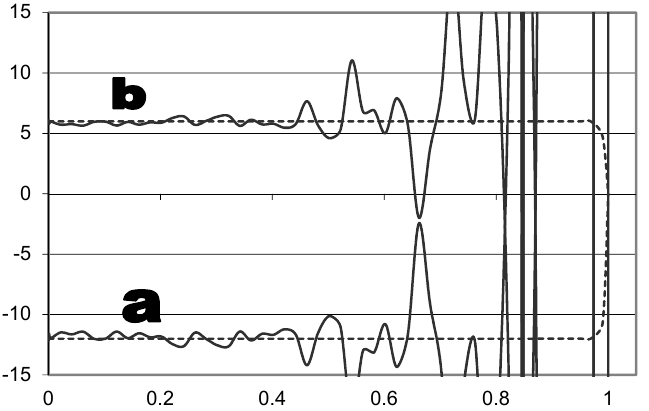
Figure 4. Shrinking horizon prediction control problem: Time ‐ varying values of integration constants computed online by a continuous predictive closed ‐ loop optimum controller. Dotted lines are no noise cases and results displayed with solid lines are run with noise. The abscissa contains time, while the ordinate displays the values of the constants. a and b in Equation (18).